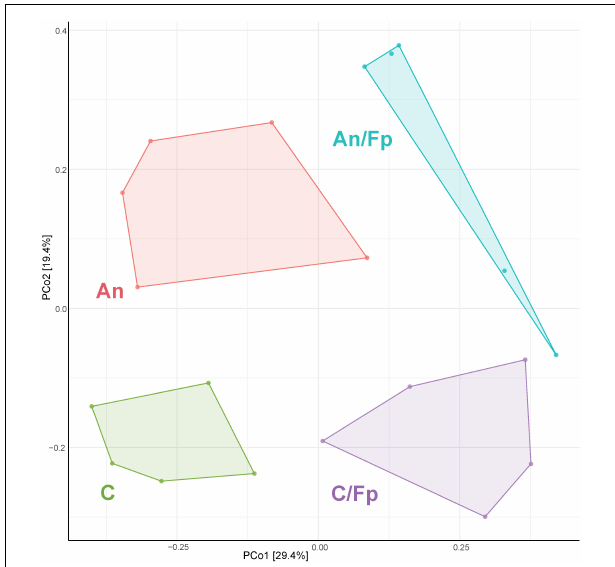
FIGURE 7 | PCoA of 20 samples and 310 OTUs (8 dpi) [The OTUs were transformed to relative abundance]. Prior to the analysis, OTU’s that are not present in more than 0.1% relative abundance in any sample have been removed. No initial data transformation has been applied. The relative contribution (eigenvalue) of each axis to the total inertia in the data is indicated in percent at the axis titles. C, control feed group; An, antibiotic feed group; C/Fp, control feed group + F. psychrophilum ; An/Fp, antibiotic feed group + F. psychrophilum .